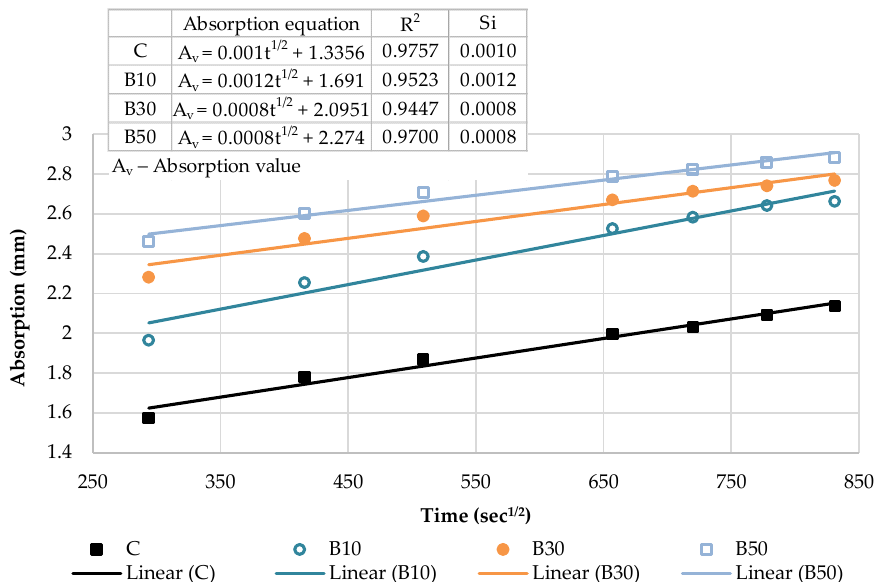
Figure 12. The secondary capillary absorptivity of biomass ash–based mortars.